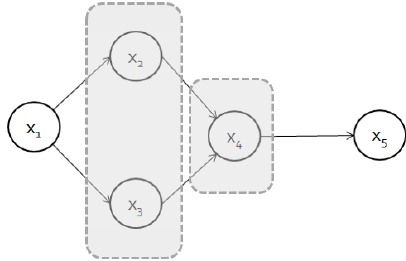
Figure 12. Example of causal inference in a Bayesian network (BN).